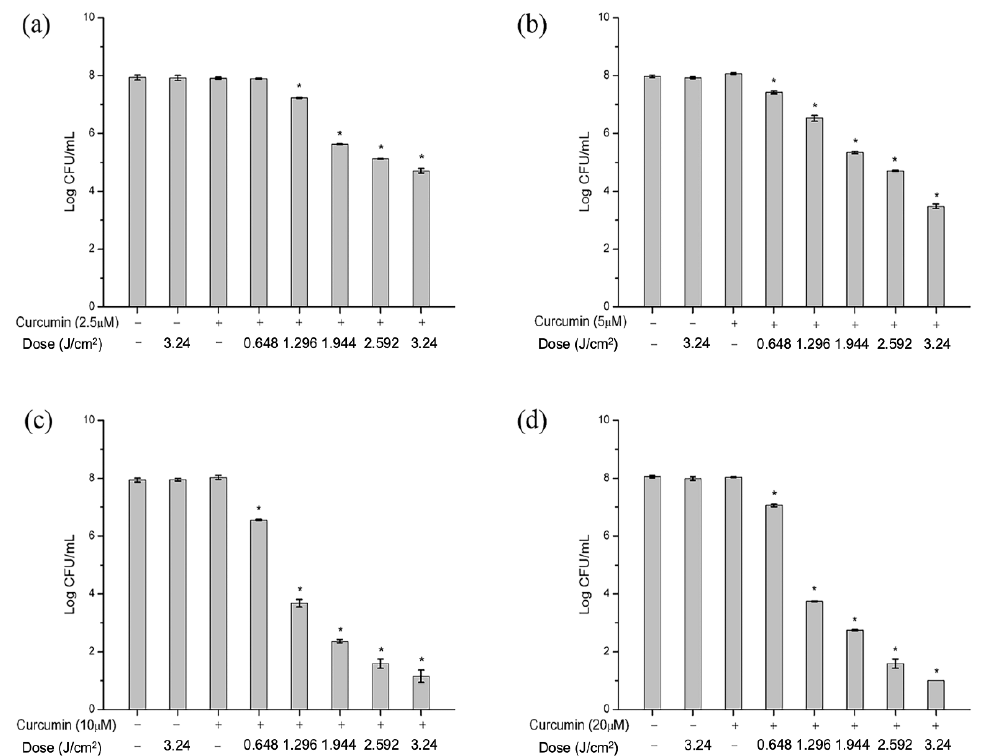
Figure 1. Effect of curcumin-based antimicrobial photodynamic treatment (aPDT) against S. aureus in PBS. ( a – d ) Different curcumin concentration (2.5, 5, 10 and 20 µ M) under (0–3.24 J/cm 2 ) illumination, respectively. Bars with an asterisk indicate significant difference ( p < 0.05) compared to the negative control.